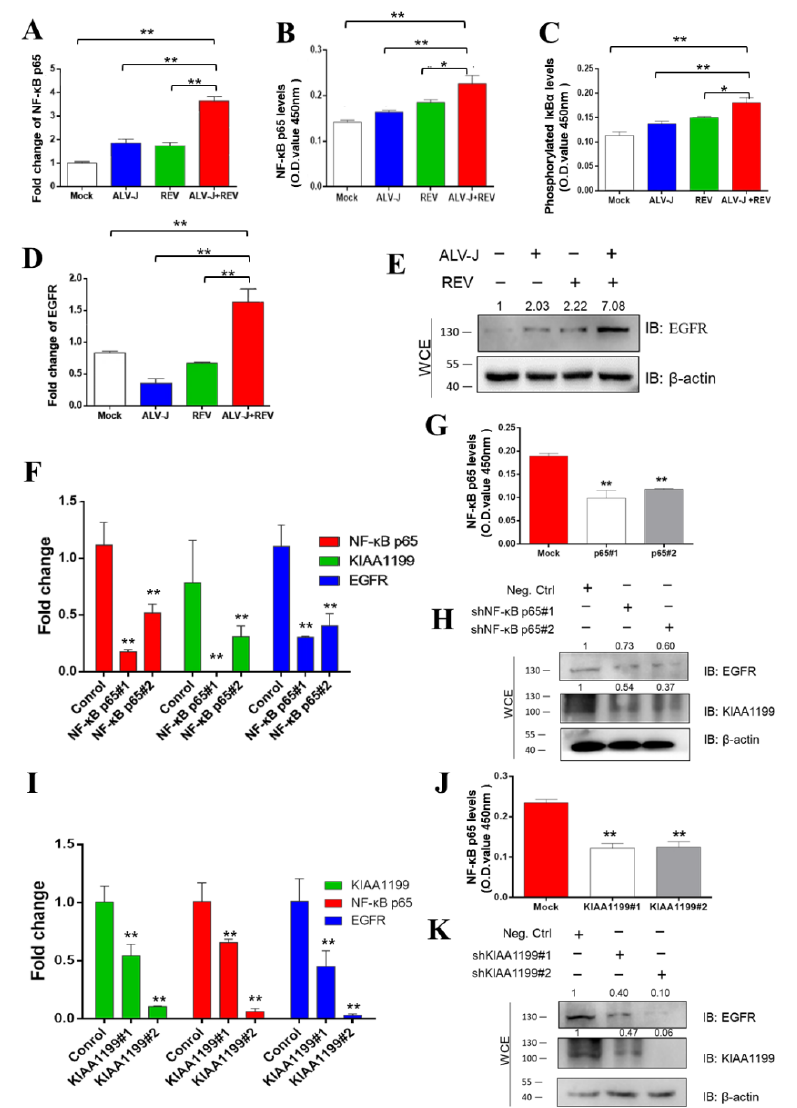
Figure 6. ALV-J and REV synergistically activated NF- κ B/KIAA1199/EGFR signaling pathway crosstalk. ( A ) Co-infection with ALV-J and REV enhanced the NF- κ B p65 mRNA expression levels in DF-1 cells at 72 hpi. ( B ) ALV-J and REV synergistically enhanced NF- κ B p65 protein levels in DF-1 cells at 72 hpi, as detected using the NF- κ B p65 ELISA kit. ( C ) ALV-J and REV synergistically enhanced phosphorylated I κ B α expression levels in DF-1 cells at 72 hpi, as detected using the phosphorylated I κ B α ELISA kit. ALV-J and REV synergistically enhanced EGFR mRNA expression ( D ) and protein ( E ) levels in DF-1 cells at 72 hpi. Protein levels were estimated using WB with anti-EGFR antibody. ( F ) mRNA expression levels of NF- κ B p65, KIAA1199, and EGFR were suppressed after incubation with NF- κ B p65 shRNA at 48 hpi. ( G ) NF- κ B p65 protein levels were inhibited by NF- κ B p65 shRNA, as detected using the NF- κ B p65 ELISA kit. ( H ) Protein levels of KIAA1199 and EGFR were suppressed by NF- κ B p65 shRNA at 48 hpi, as detected using WB with anti-KIAA1199 antibody and anti-EGFR antibody. ( I ) mRNA expression levels of KIAA1199, NF- κ B p65, and EGFR were suppressed by KIAA1199 shRNA. ( J ) Protein levels of NF- κ B p65 were inhibited by KIAA1199 shRNA, as detected using the NF- κ B p65 ELISA kit. ( K ) Protein levels of KIAA1199 and EGFR were suppressed by KIAA1199 shRNA at 48 hpi, as detected using WB with anti-KIAA1199 and anti-EGFR antibodies. Data are presented as mean ± SEM for n = 3, with each experiment being performed in triplicate. ** p ≤ 0.01 determined using Student (cid:48) s t -test versus the Neg. Ctrl. group. * p ≤ 0.05 determined using Student (cid:48) s t -test versus the Neg. Ctrl.